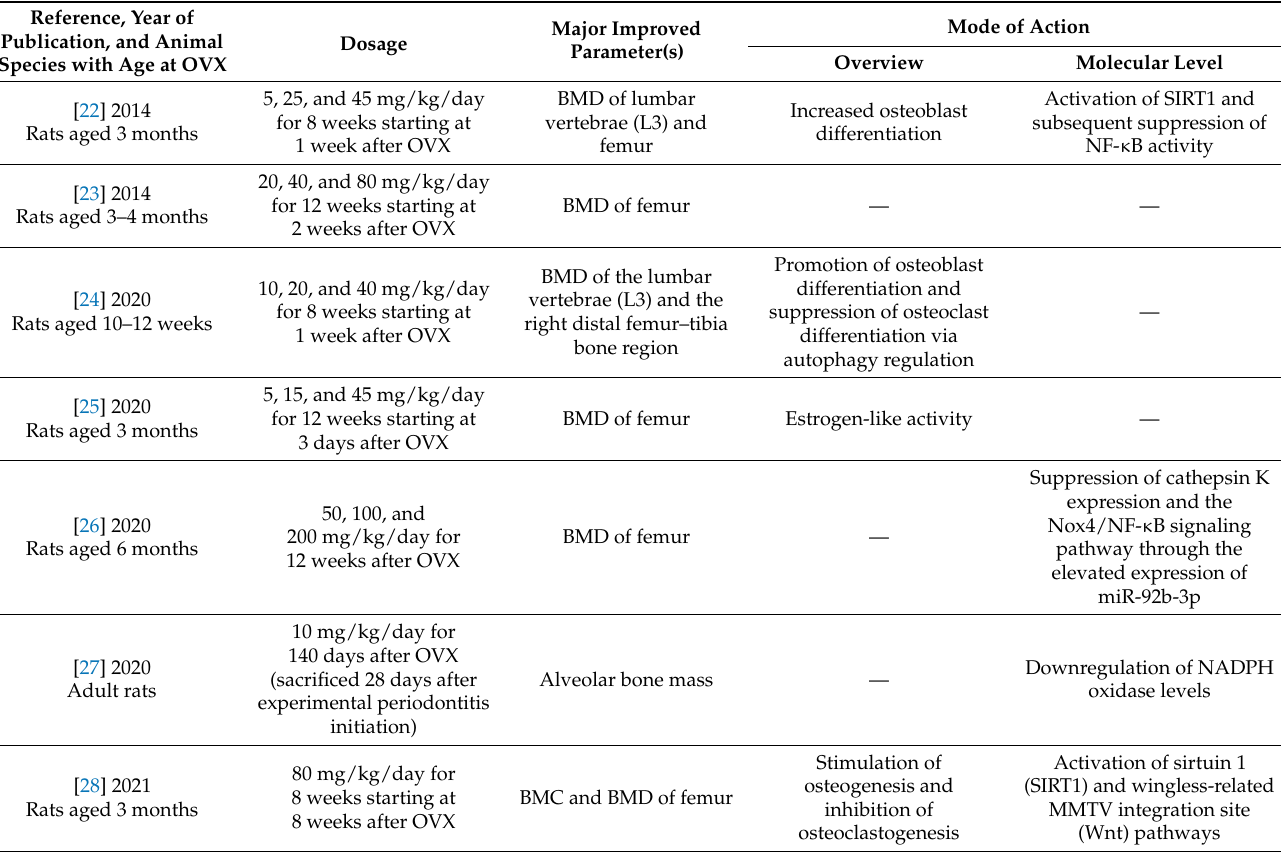
Table 1. Beneficial effects of oral resveratrol on osteoporosis in ovariectomized rodents.